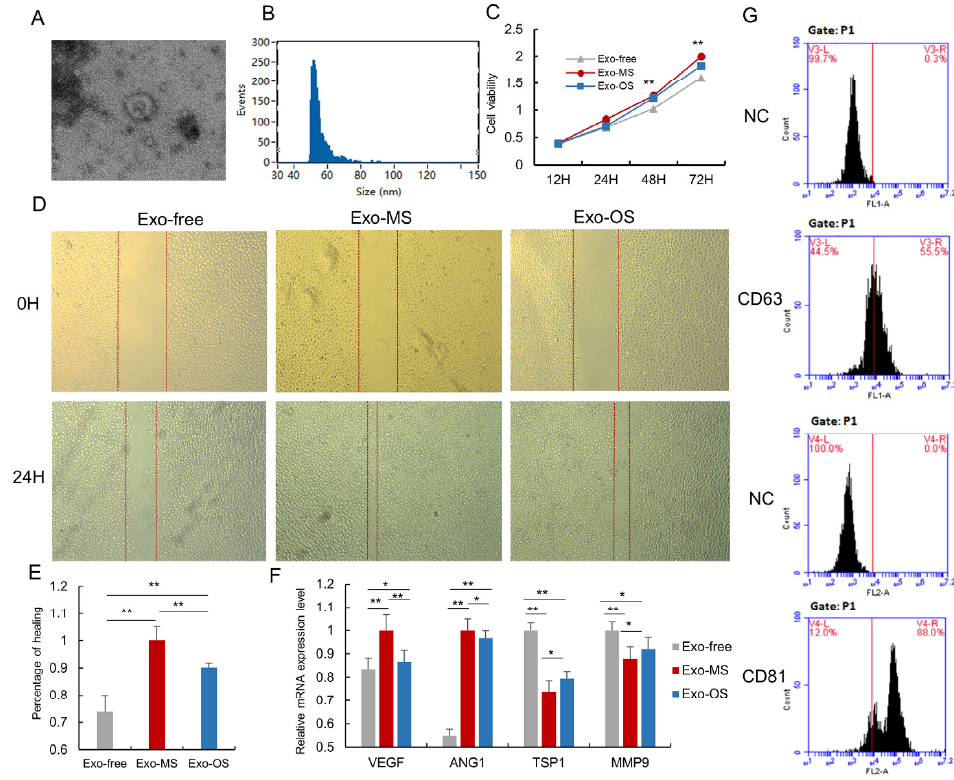
Figure 3. The pro-angiogenesis role of Exo-OS was repressed. ( A ) The 3D morphology of isolated pig UCB-EXO observed in electron microscope; ( B ) The line profile of electron microscope image size for UCB-EXO. X- and Y-axis are the size and events; ( C ) Cell viability was measured following Exo-OS, Exo-MS or PBS treatment for 24 h, using the CCK8 analysis; ( D ) The migration of HUVECs cells in vitro after 24 h of treatment with Exo-MS, Exo-OS, or PBS was evaluated using scratch assay ( n = 3); ( E ) Percentage of cells healed; ( F ) The expression level of VEGF, ANG1, TSP1 and MMP9 mRNA after treating Exo-MS, Exo-OS or PBS; ( G ) Positive rate of exosomes marker proteins CD63 and CD81 detected by flow cytometry.* or ** represents significance at the 0.05 or 0.01 level, respec- tively, and ns represents no significance.